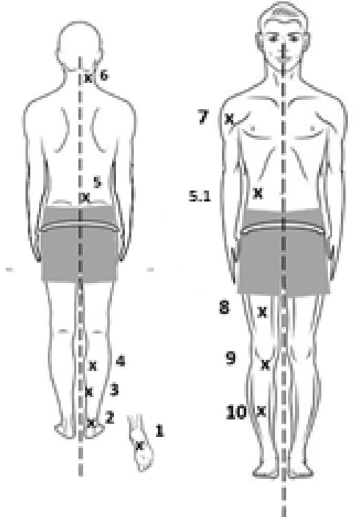
Figure 1. Dorsal (left) and Ventral (right) measurement points (right side only) are shown in body